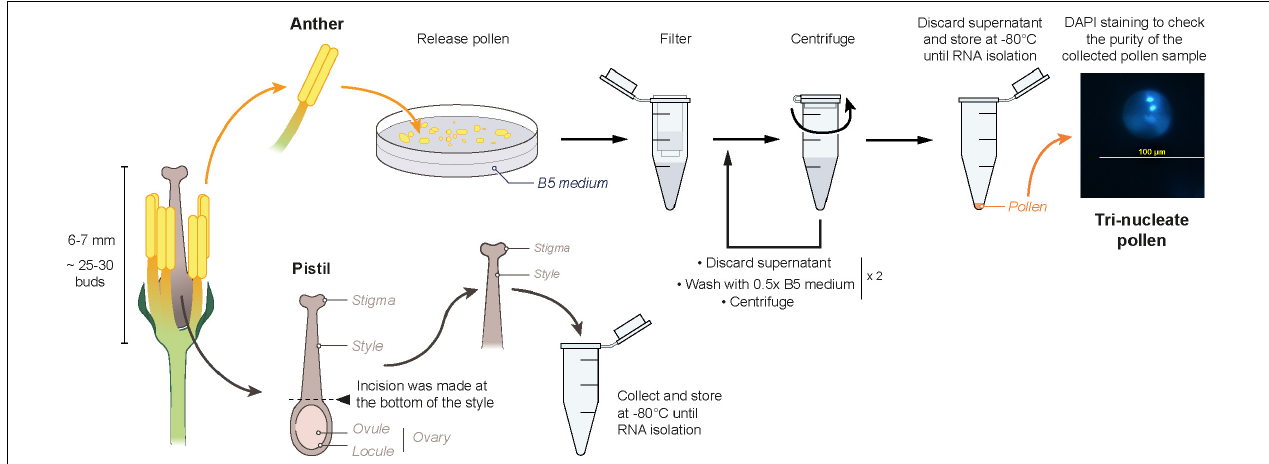
FIGURE 1 | Schematic representation of the isolation method of mature pollen and pistil (stigma + style) for RNA